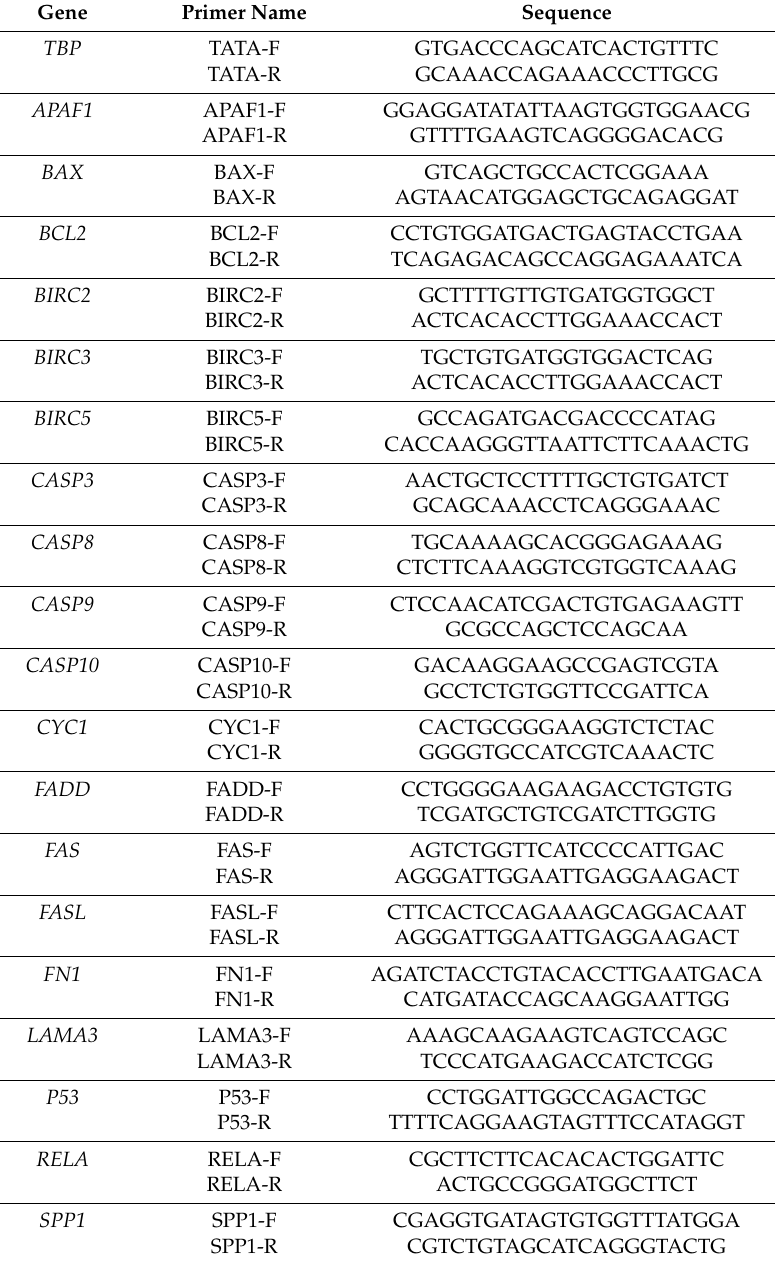
Table 2. Primer sequences for